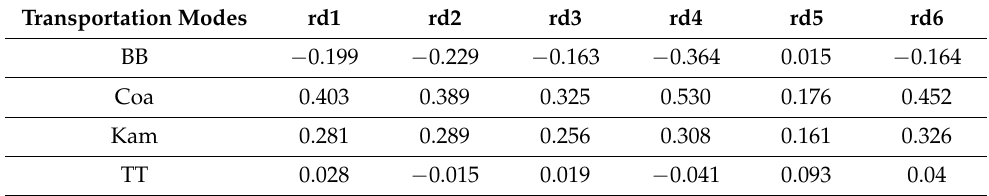
Table 9. The new MIS based on the generalized aggregation method (Equation